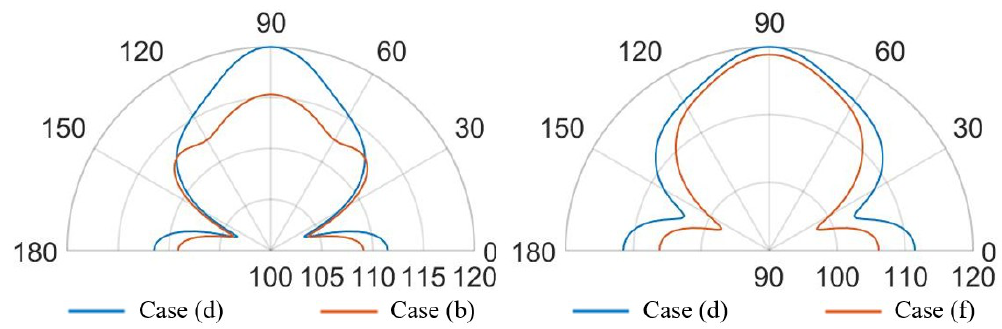
Figure 28. SPL polar plot (dB) at the performing fundamental frequency of 93.0 kHz (3 V bias), at 3.5 cm in the y(90 ◦ )–z(0 ◦ ) plane: (d) vs (b) ( left ), (d) vs (f) ( right ).